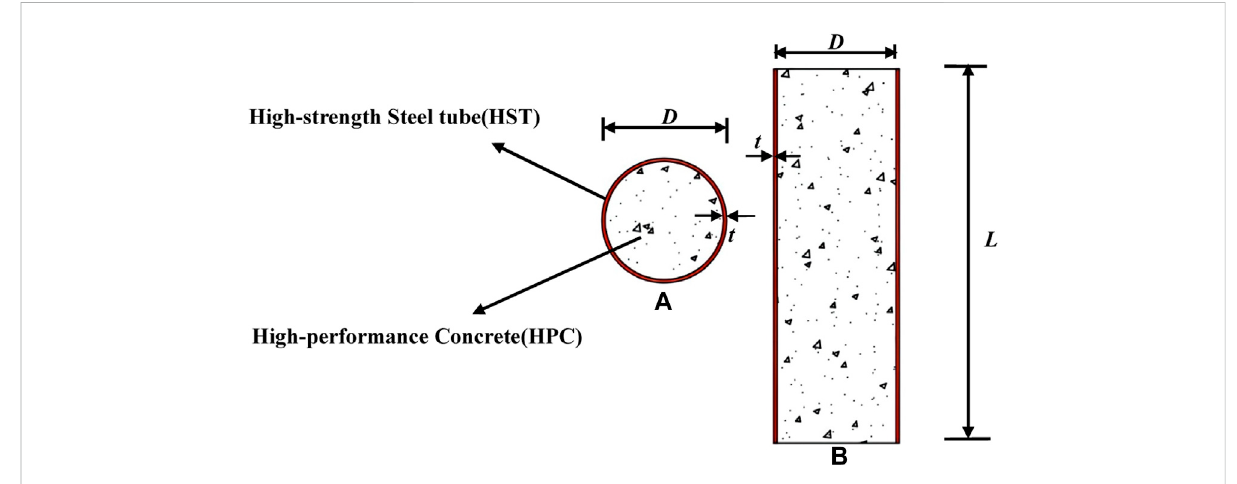
FIGURE 1 The schematic diagram and physical meaning of variables for specimens. (A) Cross section; (B) Longitudinal